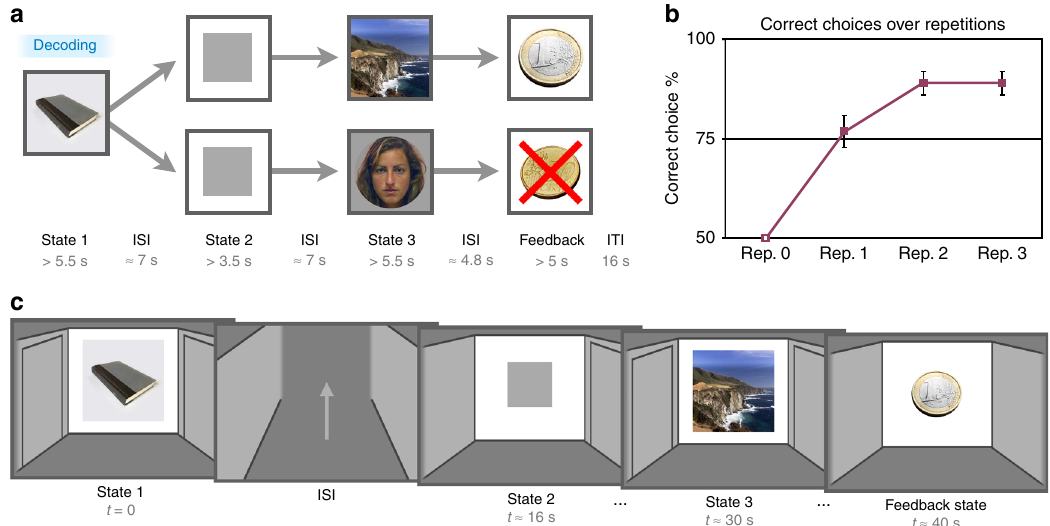
Fig. 1 Learning-phase task design and behavioral results. a Learning-phase maze trial structure. Across eight unique maze sequences, participants learned which action to make in state 1 in order to receive a deterministic reward at the end of the maze. Participants made a left or right choice in the fi rst state and then proceeded through instructed left or right choices in state 2 and state 3, followed by reward or loss in the feedback state. Maze-unique stimuli from three categories (faces, scenes, and objects) were presented in state 1 and state 3. The delay between state 1 and state 3 was on average greater than 30 s, while repetitions of unique mazes were separated by at least 4 min. Critical decoding analyses focused on representations of information about state 3 at the onset of state 1 (represented by “ Decoding ” in the blue box). b Mean learning-phase performance across four repetitions of each maze. Half of initial repetitions ended in reward and half in loss, and the resulting mean 50% level of performance is indicated by the open square at repetition 1. Error bars represent standard error of the mean. c Illustration of the participant ’ s screen view, a cartoon room with potential left and right door options followed by a path through a hallway between states. In state 2 and state 3, the instructed choice was indicated by a shift in the central stimulus to the instructed door. A localizer phase, which was used to derive classi fi ers for faces, scenes, and objects, followed the learning phase